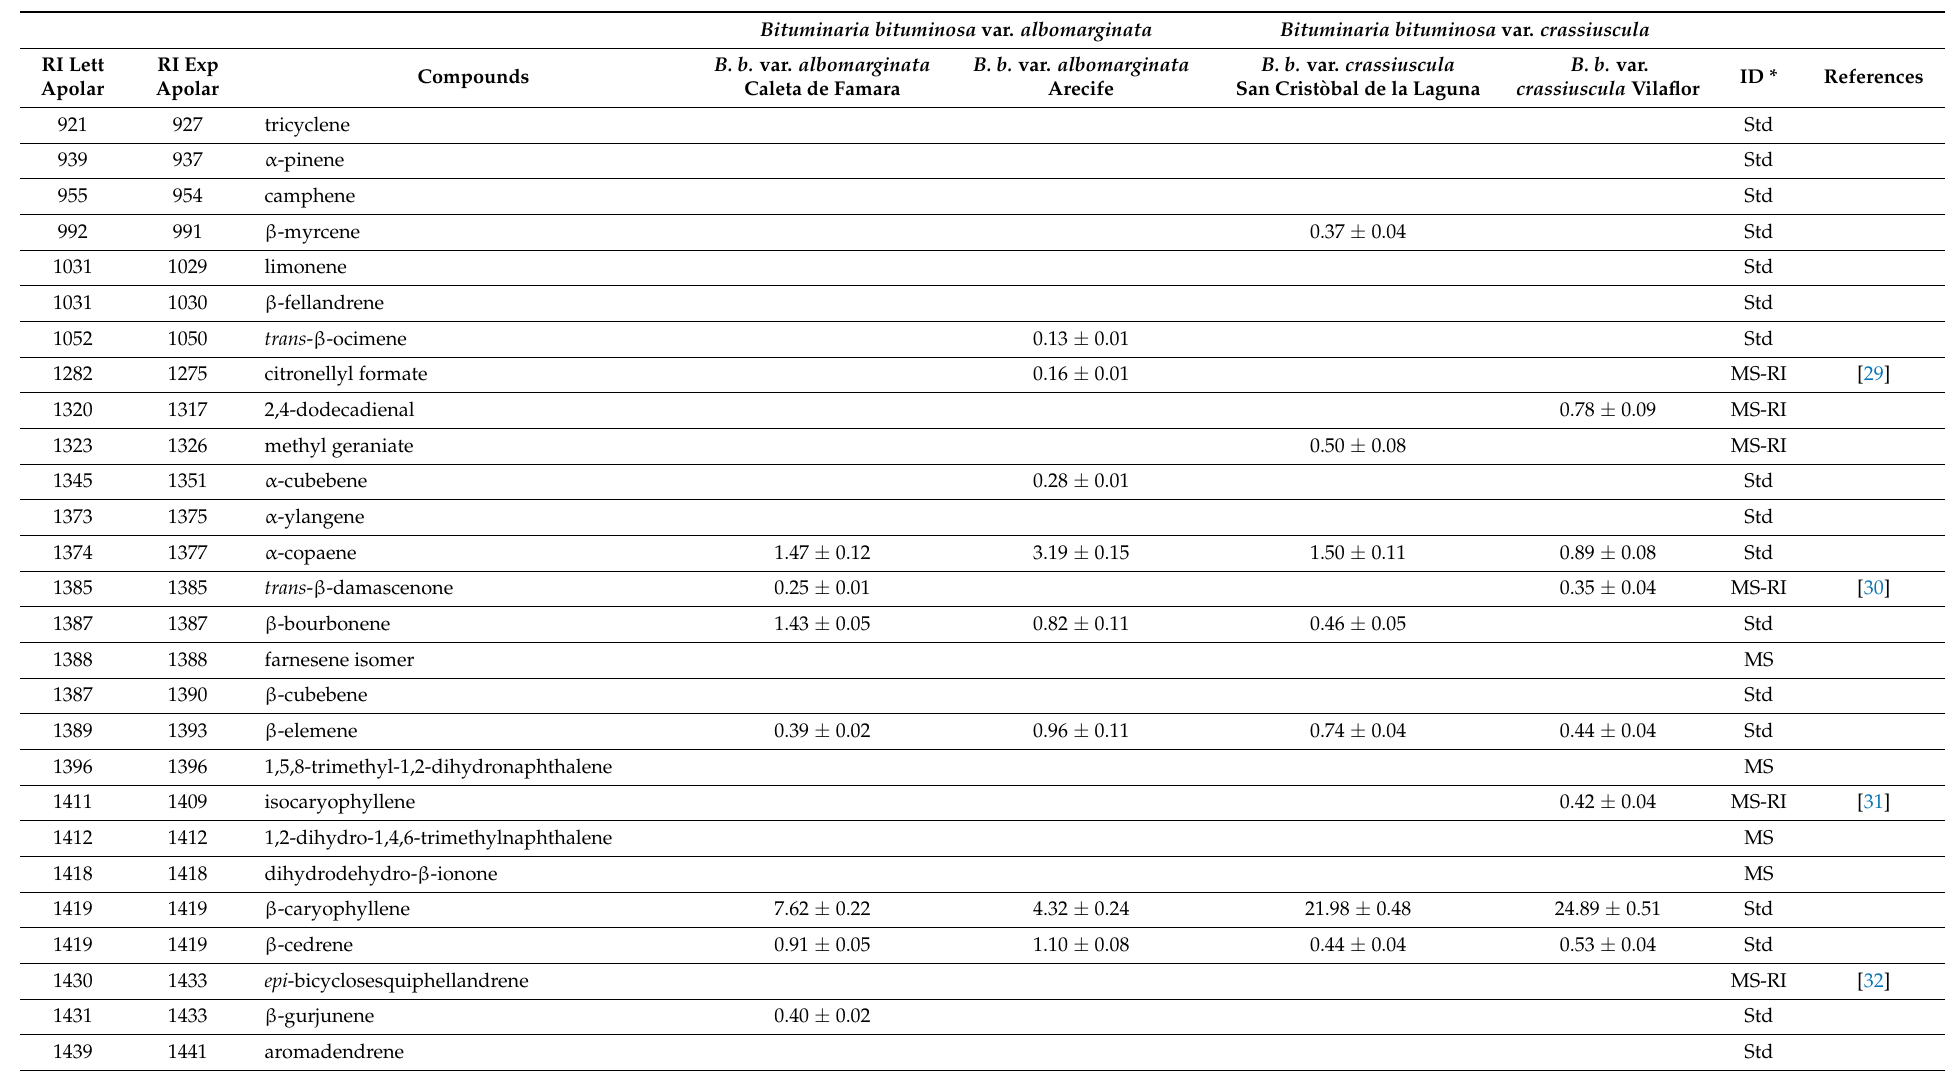
Table 2. Chemical composition of B. bituminosa var. albomarginata and B. bituminosa var. crassiuscula essential oils from Spain genotypes growing up in a Sardinian experimental field. Bituminaria bituminosa var.